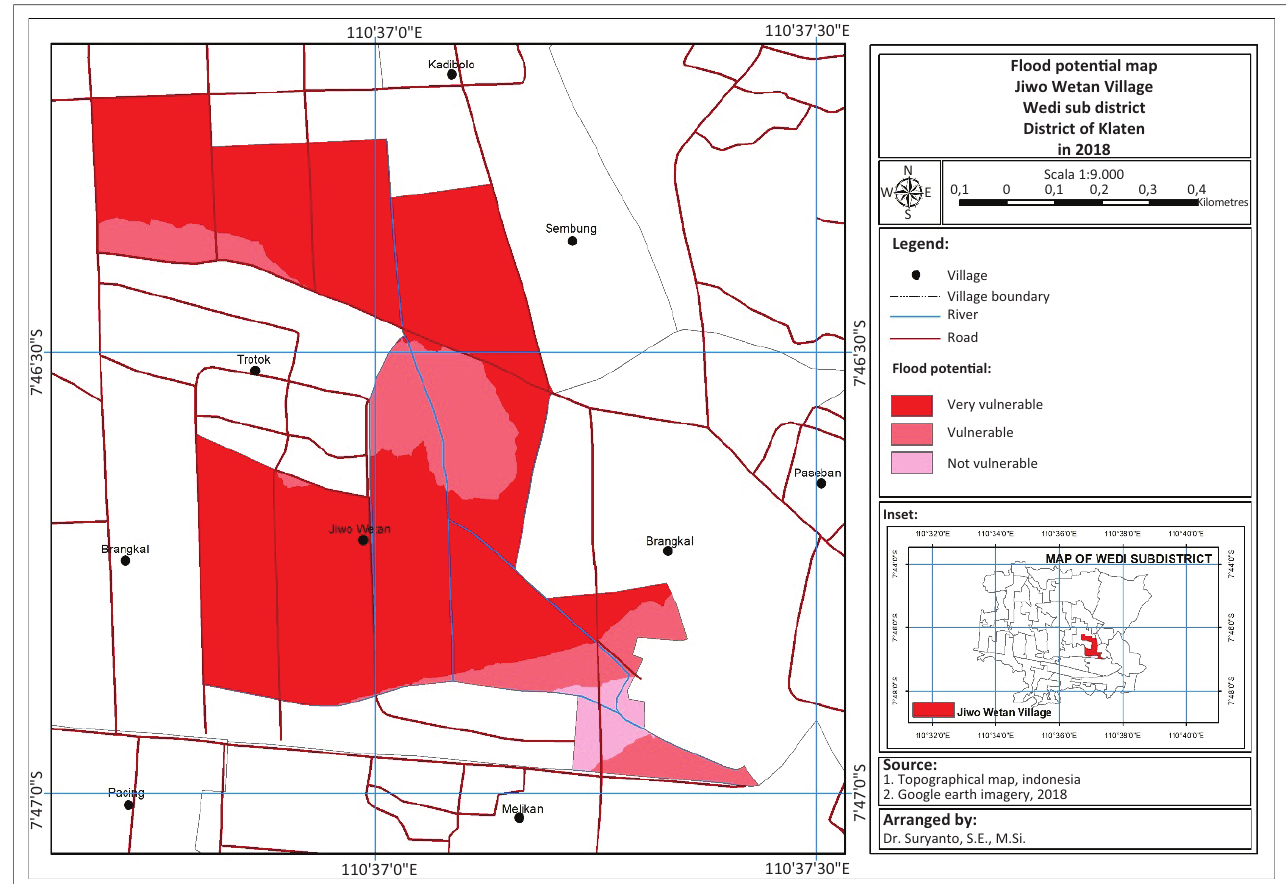
FIGURE 2: Mapping of flood-prone area in the Jiwo Wetan